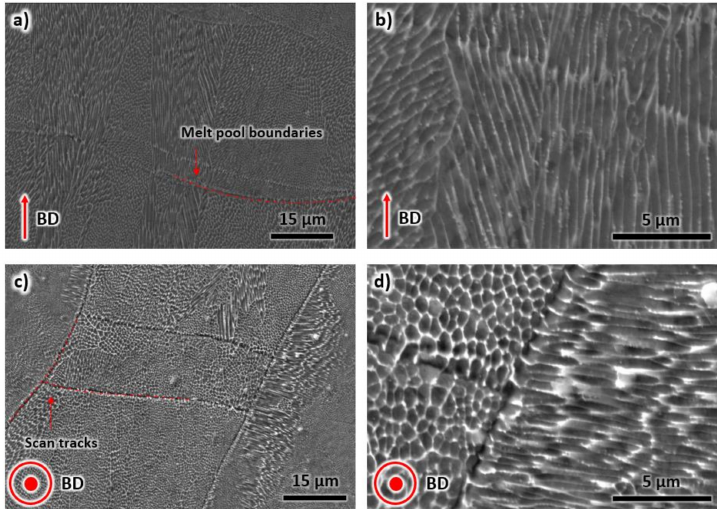
Figure 3. The scanning electron microscopy images of the as-printed samples taken from ( a , b ) building direction, and ( c , d ) transverse